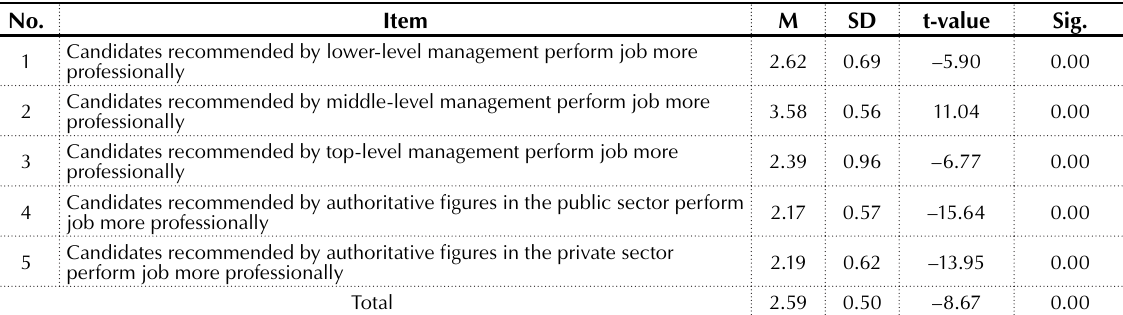
Table 4. Means, standard deviations, t-values, and significance levels of the impact of